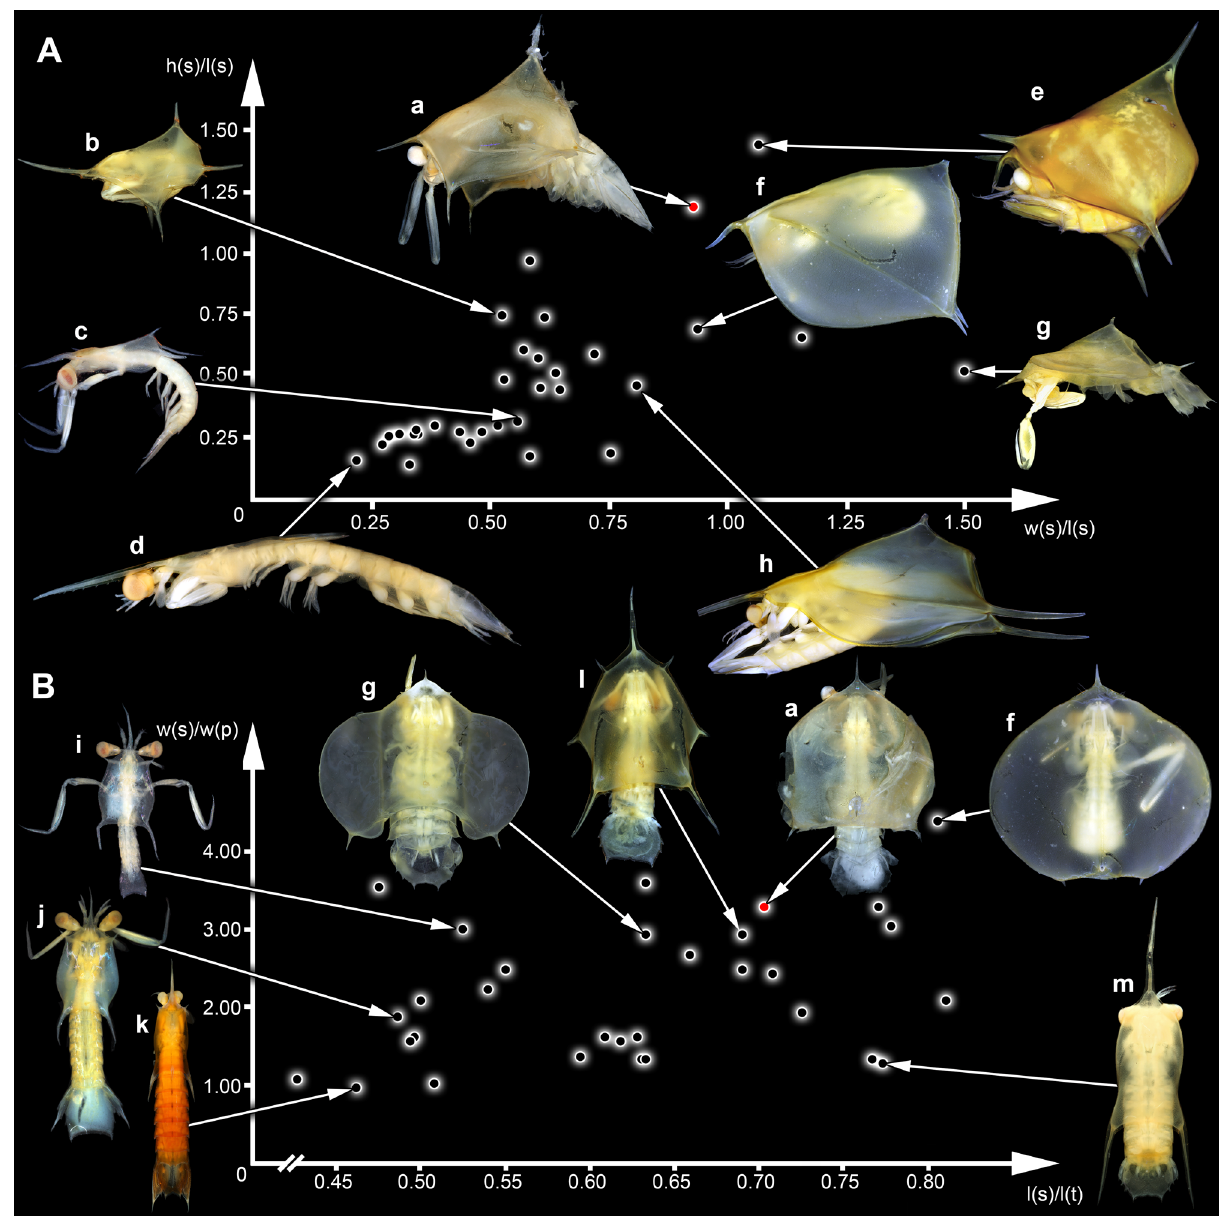
Figure 5. Scatter plots of measured dimensions and images of different specimens. A. Plot of height to length ratio of the shield against width to length ratio of the shield. B. Plot of shield width to pleon width ratio against shield length to total length ratio. a. new morphotype 5 “spiked helmet” (30023A); b. erichthus-type with neither “normal” nor “extreme” shield dimensions (NHMD- 232172); c. early erichthus-type larva (NHMD-232163); d. elongate erichthus-type larva of the “Jurassic” type (NHMD-232169); e. extreme larva of morphotype 4 “gnome hat larva” (NHMD-86465, originally labeled as ZMUC-CRU-8661); f. extreme larva of morphotype 1 “balloon larva” (NHMD-86466, originally labeled as ZMUC-CRU-8662); g. extreme larva of morphotype 3 “flying saucer” (NHMD-86470, originally labeled as ZMUC-CRU-8666); h. extreme larva of morphotype 2 “spiny balloon” (NHMD- 86469, originally labeled as ZMUC-CRU-8665); i. early erichthus-type larva (NHMD-232162); j. early erichthus-type larva with a relatively narrower and slightly shorter shield than i (NHMD-232179); k. elongate erichthus-type larva of the “Jurassic” type (NHMD-232167); l. erichthus-type with shield slightly narrower and shorter than in new morphotype 5 (NHMD-232170); m. erichthus-type with relatively narrow but long shield